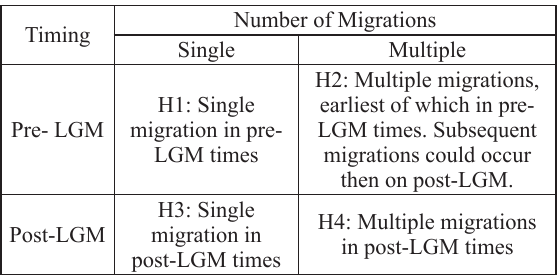
Four hypotheses of the peopling of the Americas (from Meltzer 2003: